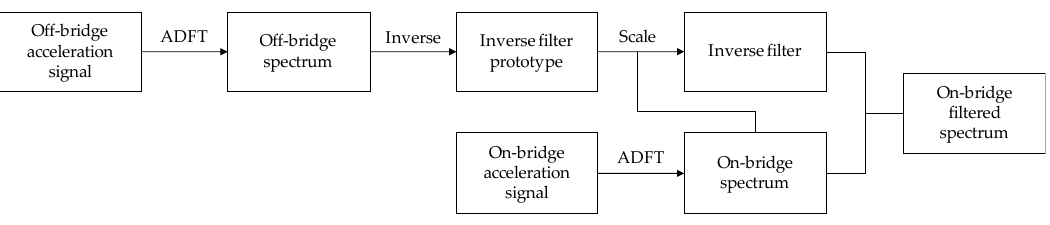
Figure 4. Hypothetical on-bridge unfiltered (red) and filtered (blue) spectrums.